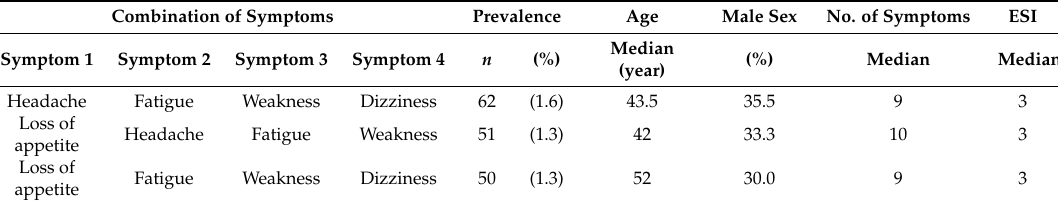
Table A2. Distribution of the 3 most frequent combinations of four